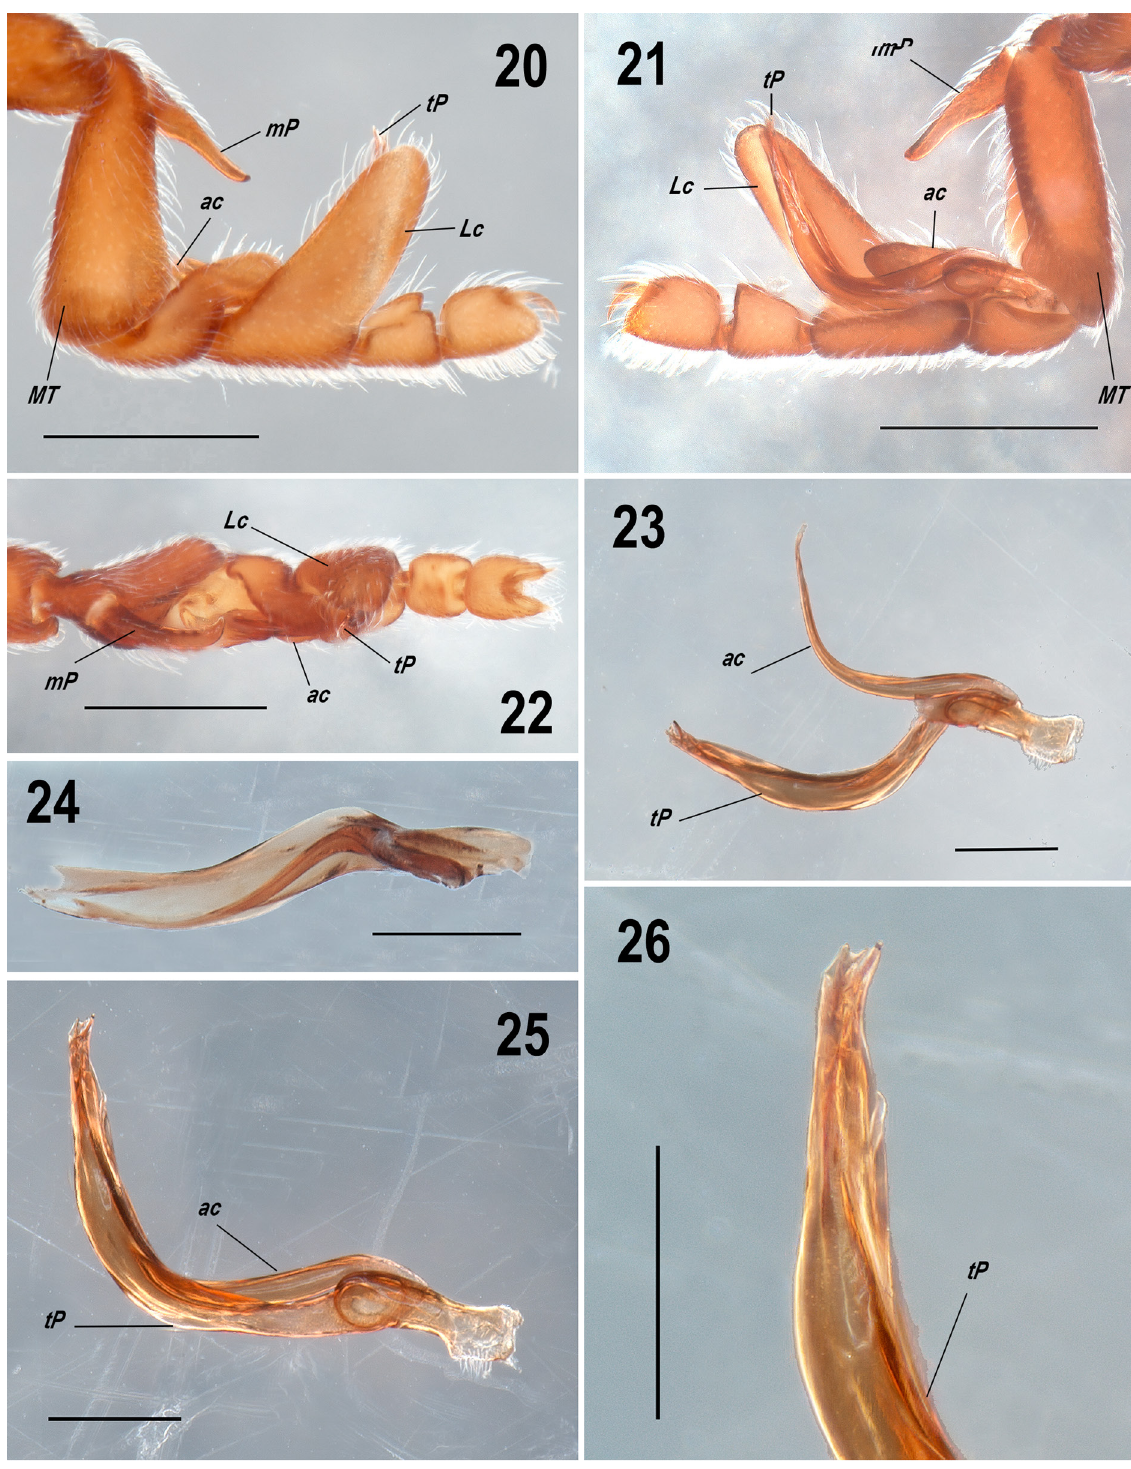
Figs 20–26. Pseudocellus giribeti sp. nov. Holotype, ♂ (MCZ 80010). 20–22 . Right leg III (copulatory apparatus), retrolateral, prolateral and dorsal views. 23 . Copulatory apparatus extended, prolateral view. 24 . Copulatory apparatus, dorsal view. 25 . Copulatory apparatus, prolateral view. 26 . Tarsal process, distal half, prodorsal view. Scale bars: 20–22 = 0.5 mm; 23–25 = 0.2 mm; 26 = 0.1